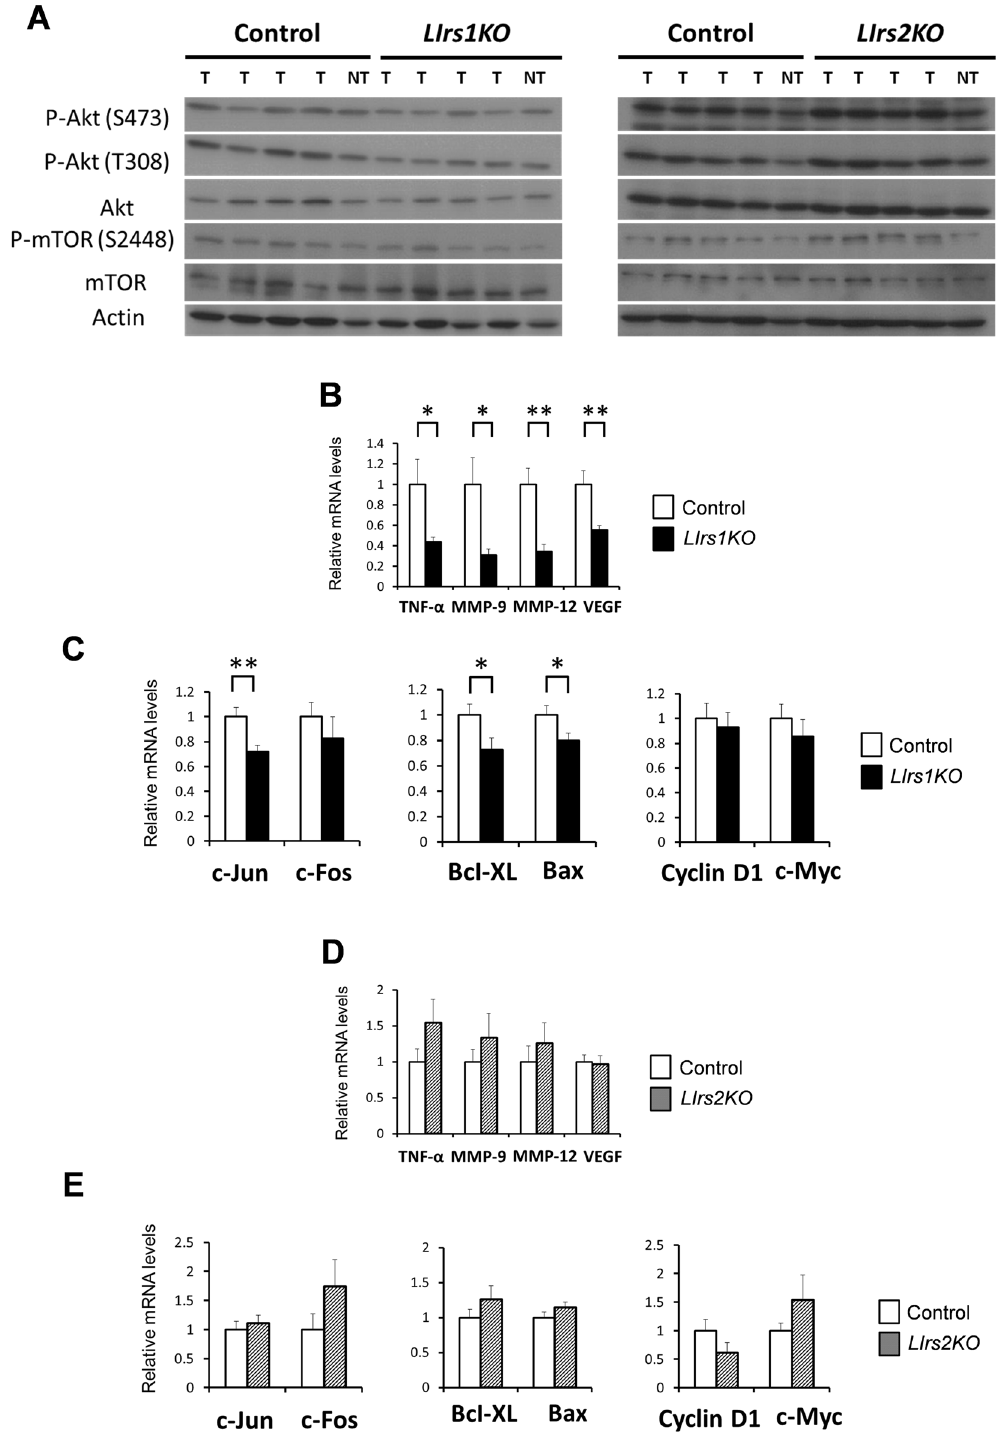
Figure 4. Tumors from DEN-treated LIrs1KO mice exhibit decreased activation of Akt, along with the decreased expression levels of genes related to inflammation and invasion. ( A ) Phosphorylation and protein expression levels of Akt and mTOR. Lysates from tumors (T) and non-tumor tissues (NT) in each DEN-treated mouse group were immunoblotted with the indicated antibodies. ( B – E ) RT-PCR analysis of indicated genes in tumors from DEN-treated LIrs1KO and DEN-treated control mice ( B and C ), or DEN-treated LIrs2KO and DEN-treated control mice ( D and E ). B and C , n = 10–12; D and E , n = 7–8. Values are the means ± SEM of data obtained from the analysis of each group. * P < 0.05. ** P <